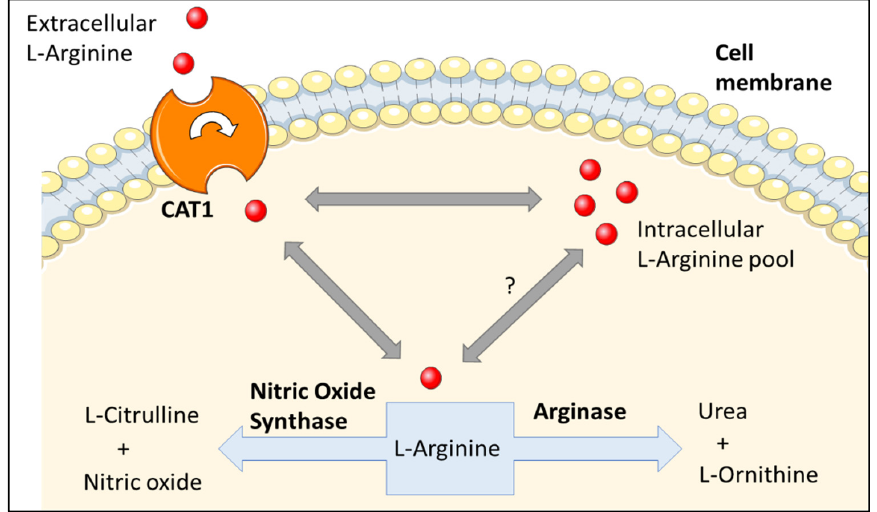
Figure 2. Schematic diagram of the L-arginine uptake and utilization by the cell. L-arginine is transported by the cationic amino acid transporter (CAT1). Inside the cell, L-arginine is thought to be present in poorly interchangeable pools that can be slowly depleted or replenished, thus accounting for the arginine paradox. The diagram was created using Servier® medical art https://smart.servier.com/ [58].